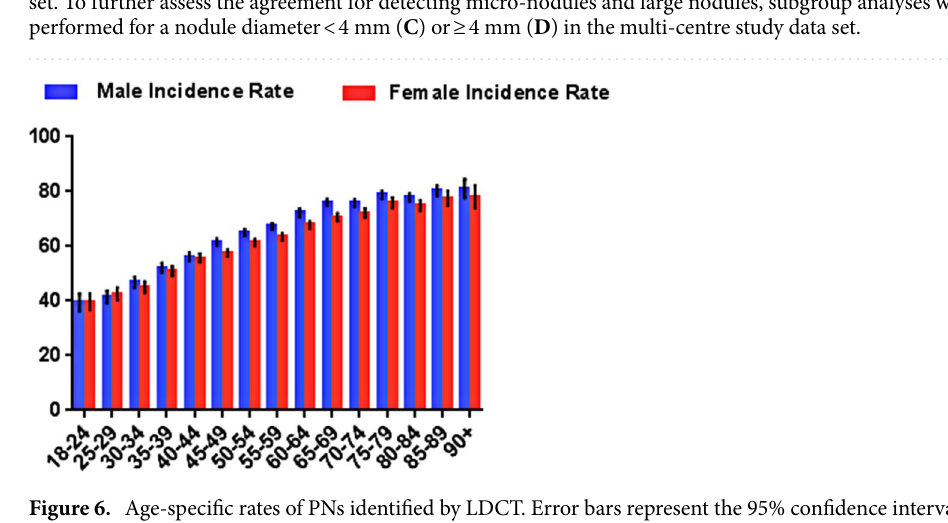
Figure 6. Age-specific rates of PNs identified by LDCT. Error bars represent the 95% confidence